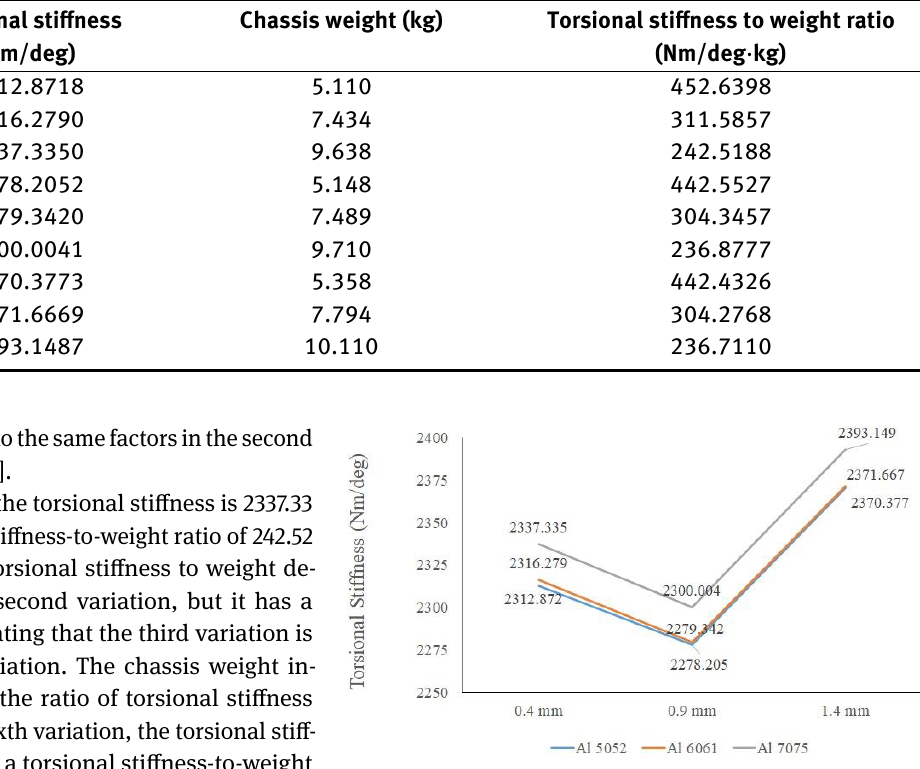
Table 11: Comparison of the torsional stiffness to the weight load